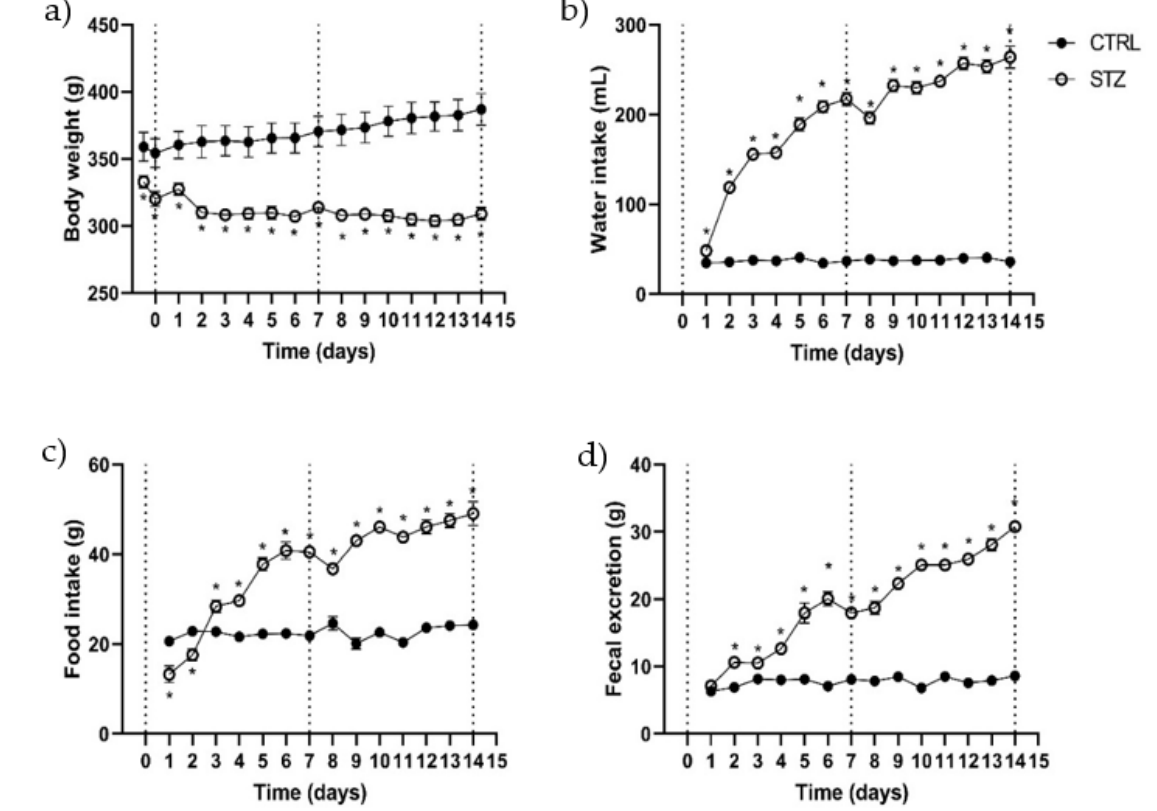
Figure 1. Evaluation during the experimental protocol (14 days) in control (CTRL, n = 8) and streptozotocin-induced diabetic rats (STZ, n = 16–21) of: ( a ) body weight; ( b ) water intake; ( c ), food intake and ( d ) fecal excretion. Values are mean ± SEM and unpaired student’s t test was used to compare the two experimental groups (CTRL and STZ). * Statistical difference, p < 0.05.